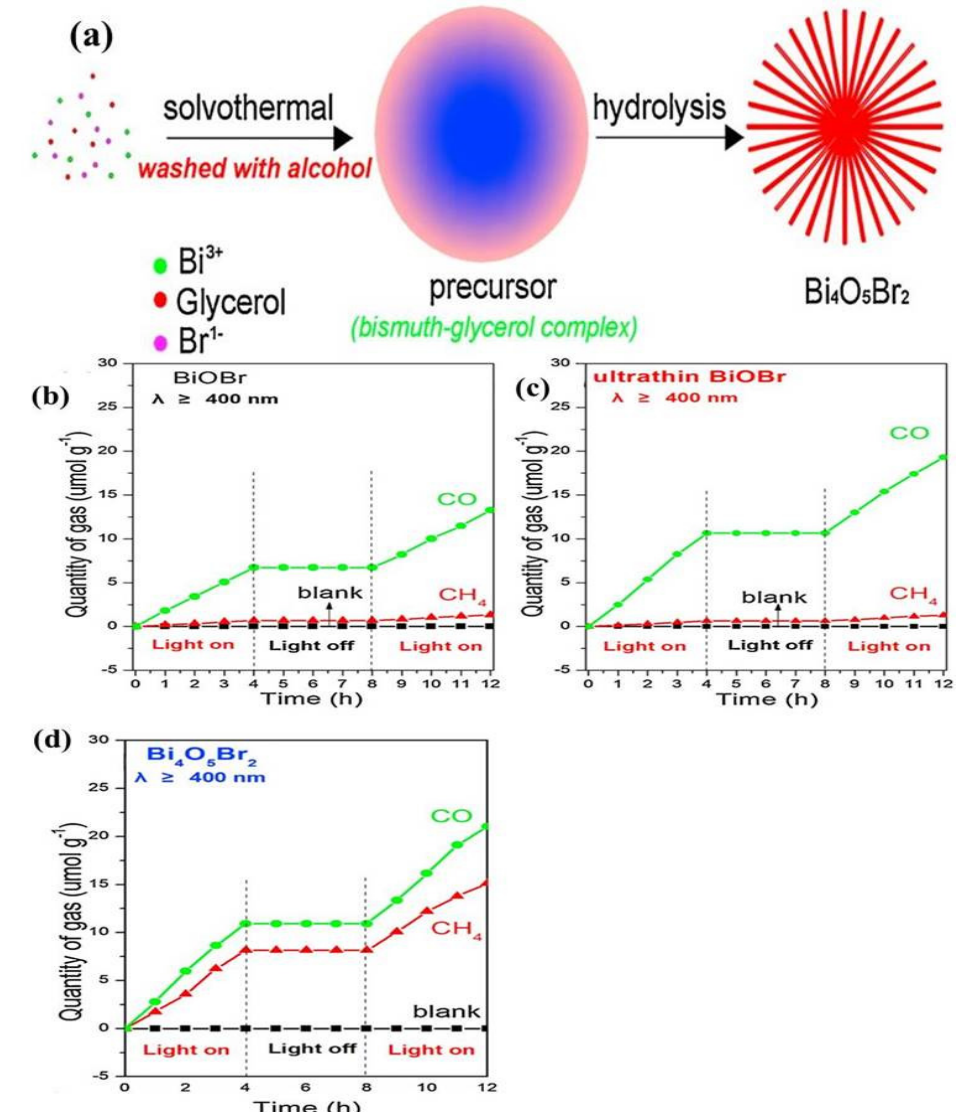
Figure 10. ( a ) Preparation process of Bi 4 O 5 Br 2 using glycerol precursor route, photocatalytic CO 2 reduction activity of ( b ) BiOBr, ( c ) ultrathin BiOBr, and ( d ) Bi 4 O 5 Br 2 . Reproduced with permission [133], Copyright 2016, Elsevier.